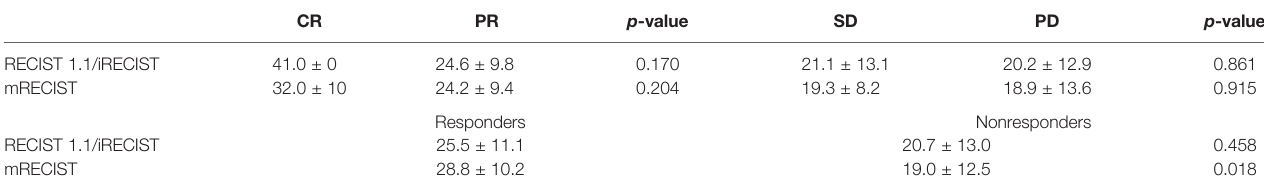
TABLE 5 | Compares overall survival (months) between patients with CR and PR and patients with SD and PD and between responders and nonresponders according to different response assessment methods.